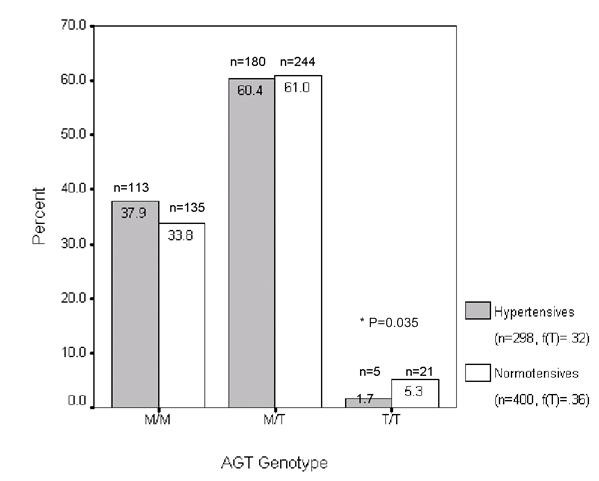
AGT genotypes and allele frequencies in women (significant at p = 0.035). F(T): frequency of T- allele.